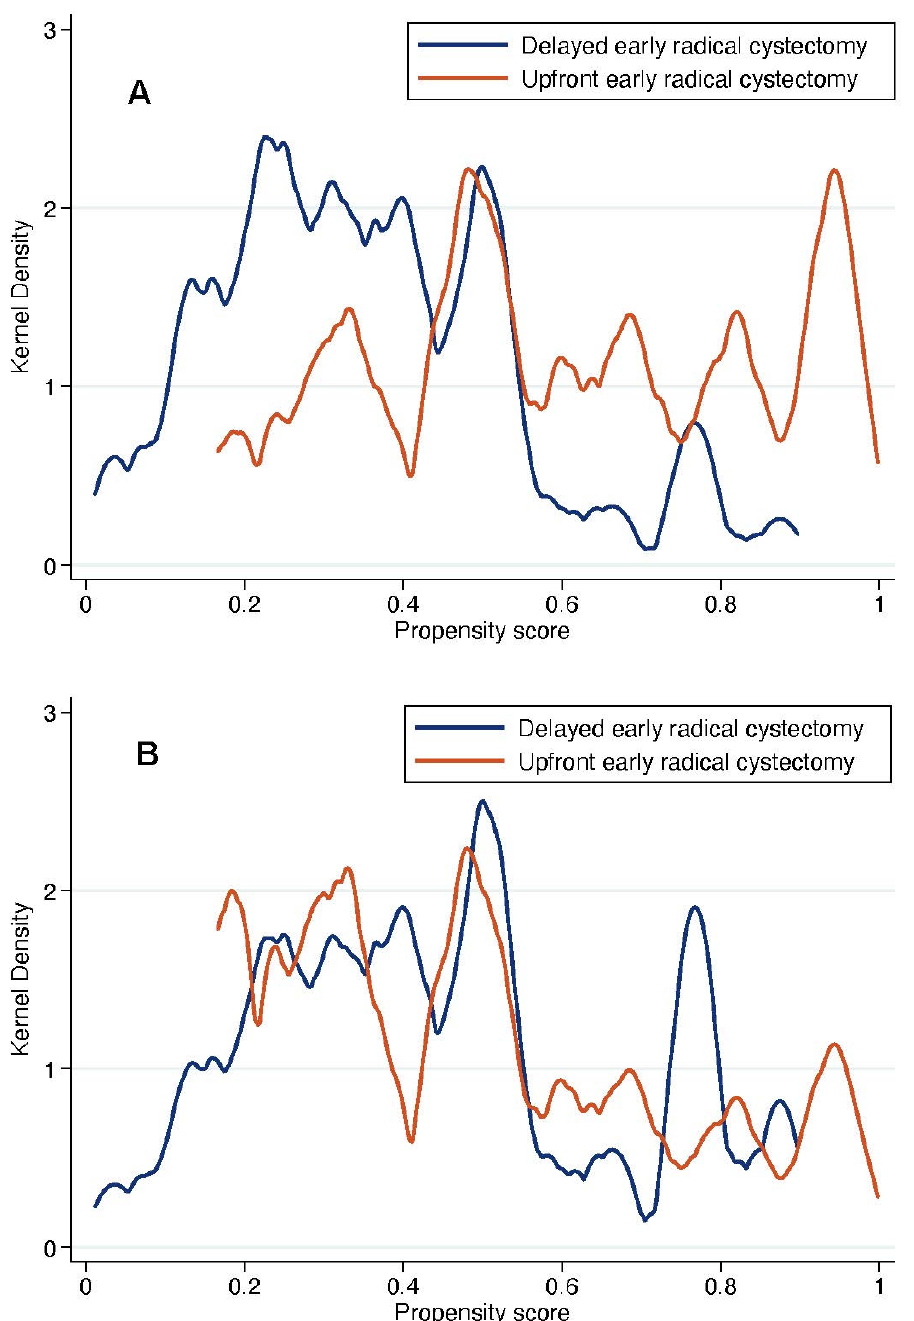
Figure 5. Kernel density plots that show the distribution of propensity scores in included patients treated with upfront or delayed eRC groups before ( A ) and after ( B ) adjustment by inverse probability of treatment weighting (IPTW) method.